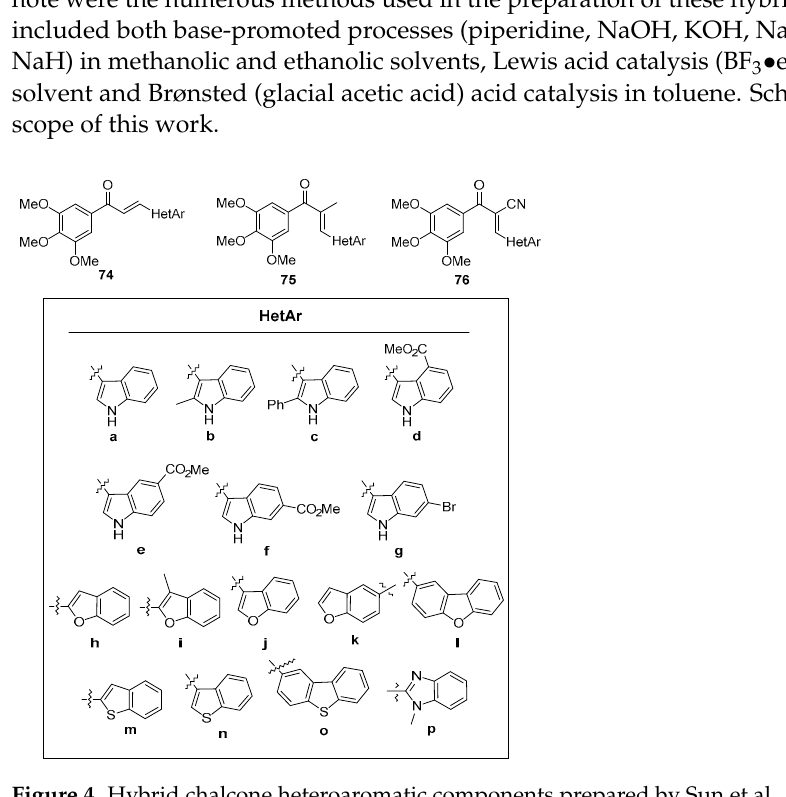
reaction time. Jadhava’s team used PEG-400 as a benign solvent to mediate the condensation of 4-fluoroacetophenone 84 and a series of pyrazole carbaldehydes 85 en route to